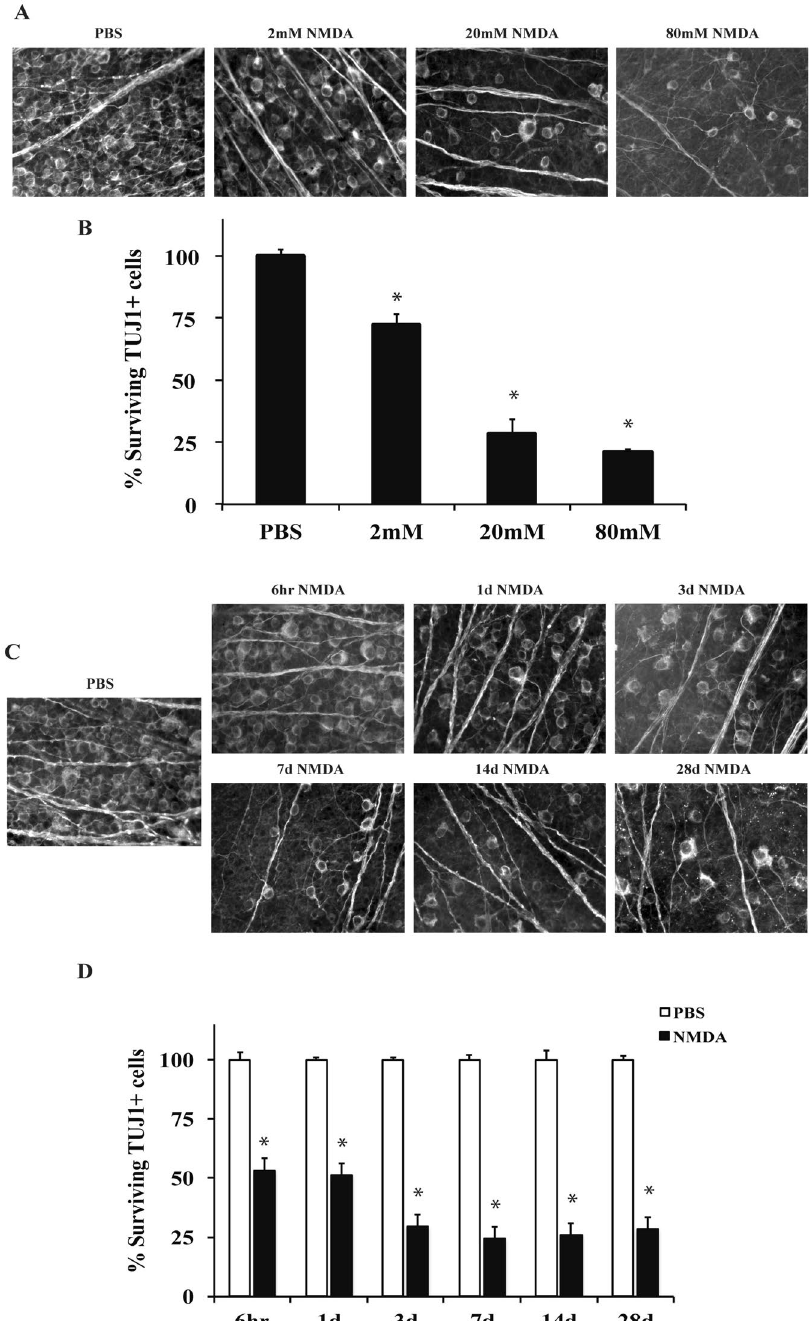
Figure 1. NMDA induced excitotoxic insult kills RGCs in a dose dependent manner. RGC loss was quantified 7 days after intravitreal injection of NMDA. ( A , B ) The RGC specific marker, TUJ1, was used to label RGCs in flat-mounted retinas 7 days after a 2 μ l intravitreal injection of either PBS (vehicle control) or 2 mM, 20 mM, or 80 mM of NMDA into C57BL/6 J mice (n = 23 for PBS control, n = 6 for 2 mM NMDA, n = 6 for 20 mM NMDA, n = 3 for 80 mM NMDA). Quantification of TUJ1 + RGCs showed NMDA insult caused a dose dependent loss of RGCs. All NMDA concentrations caused a significant decrease in RGC number ( * p < 0.001 for all comparisons). Note, that there was no significant difference in RGC number between the 20 mM and 80 mM concentrations ( p = 0.819). ( C , D ) 20 mM NMDA was shown to induce greater than 50% RGC death at 7 days and there appeared to be no benefit to increasing the dose. Thus, 20 mM of NMDA was chosen to investigate the molecular pathways controlling NMDA induced RGC death. To understand the time course of RGC death induced by 20 mM of NMDA, TUJ1 + cells were counted in flat-mounted retinas 6hr, 1d, 3d, 7d, 14d, and 28d after (n ≥ 5 for all time points). NMDA injection resulted in significant loss of RGCs compared to controls at all time points examined ( * p < 0.001). Note, approximately 50% of TUJ1 + cells were lost after 6 hours and after 3 days, no more apparent loss of TUJ1 + cells. Scale bar: 50 μ